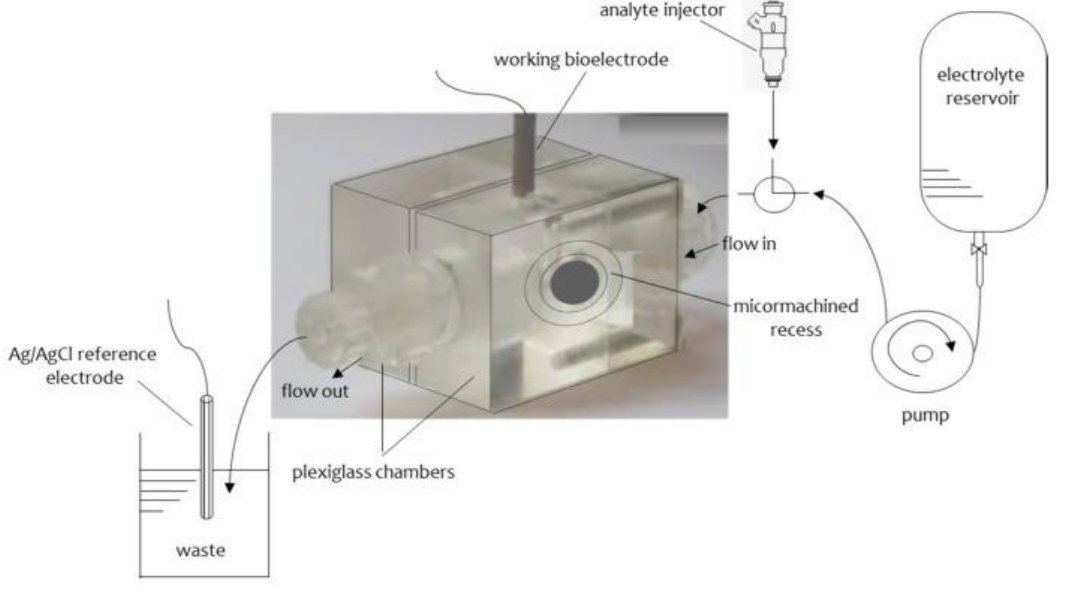
Figure 6. A diagram of the set-up for the formation of lipid membranes that were stable in electrolyte solution (from [64]).